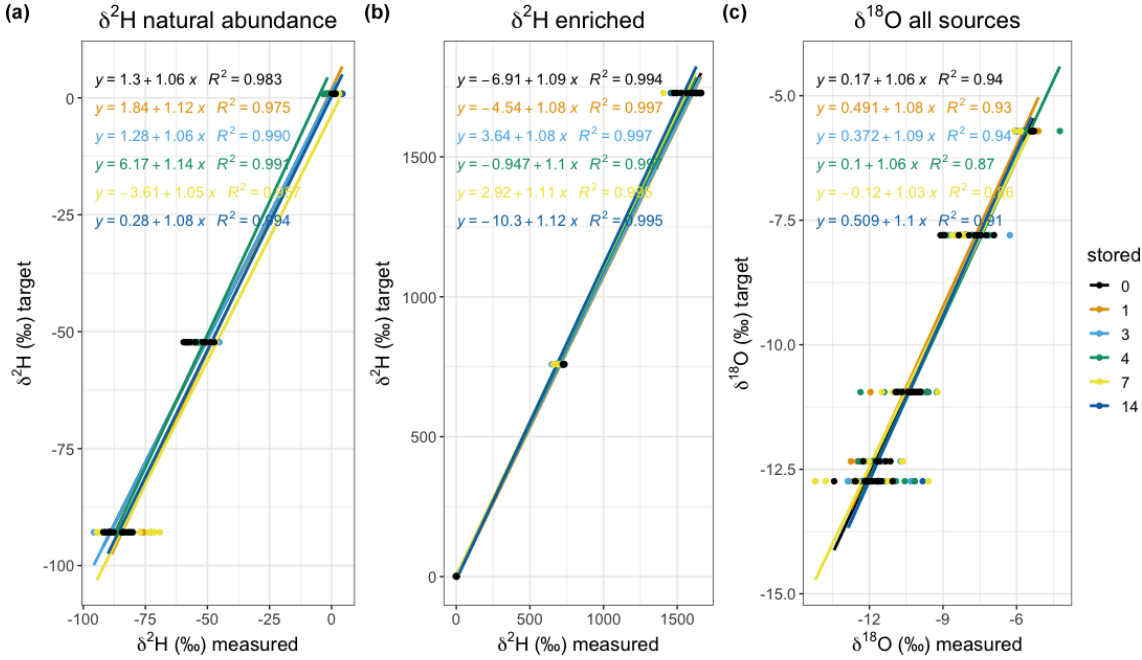
Figure 6. Linear regression through δ 2 H of the natural abundance (a) , enriched (b) , and δ 18 O (c) sources grouped by storage time (days) for the lab trial. All models are significant on a level α = 0.05. The regression equation and R 2 are plotted in the colour of the data points and the fit (see legend for colour